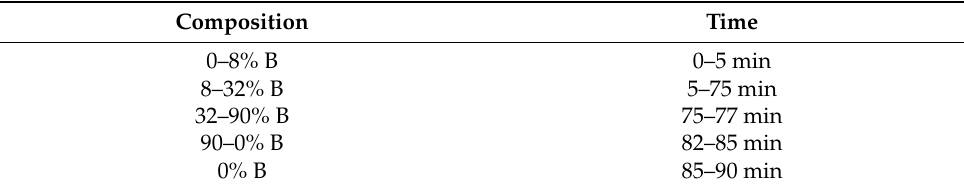
Table 1. The gradient conditions of the nano liquid phase